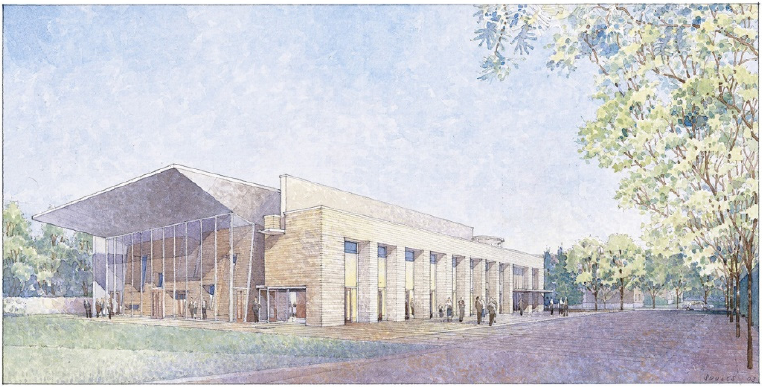
Figure 3. A water colour rendering of the iterative scheme incorporating a “trombe” wall (Credit: Jon Soules).